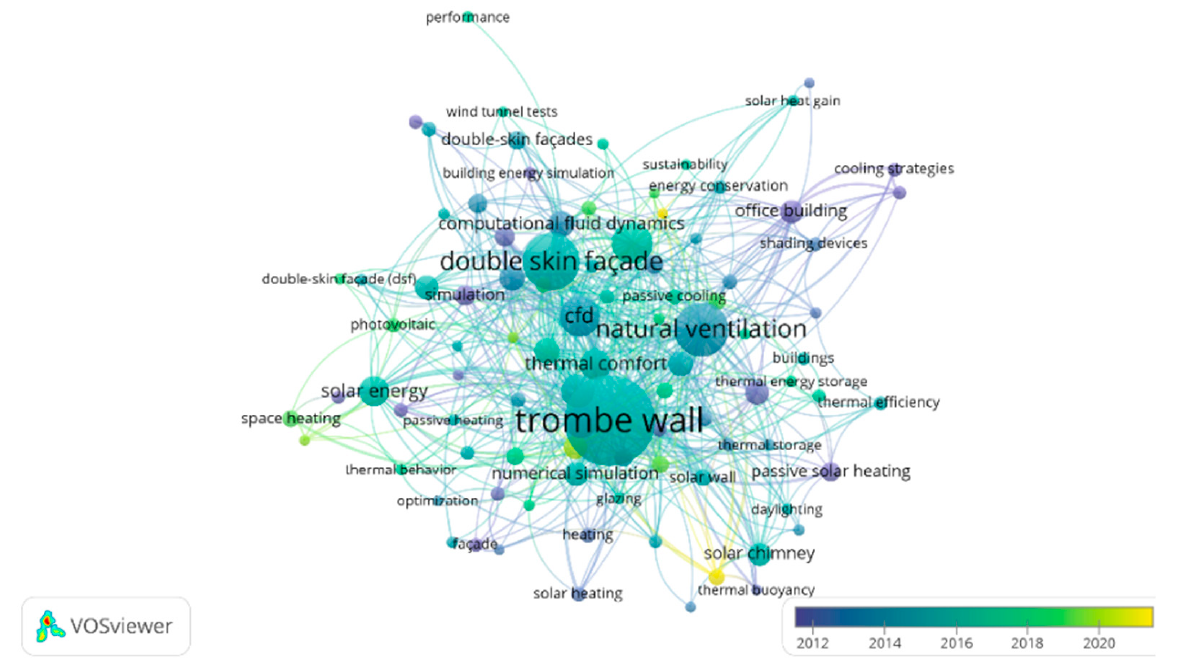
Figure 20. The network map of keyphrases (accessed on 21 January 2022).